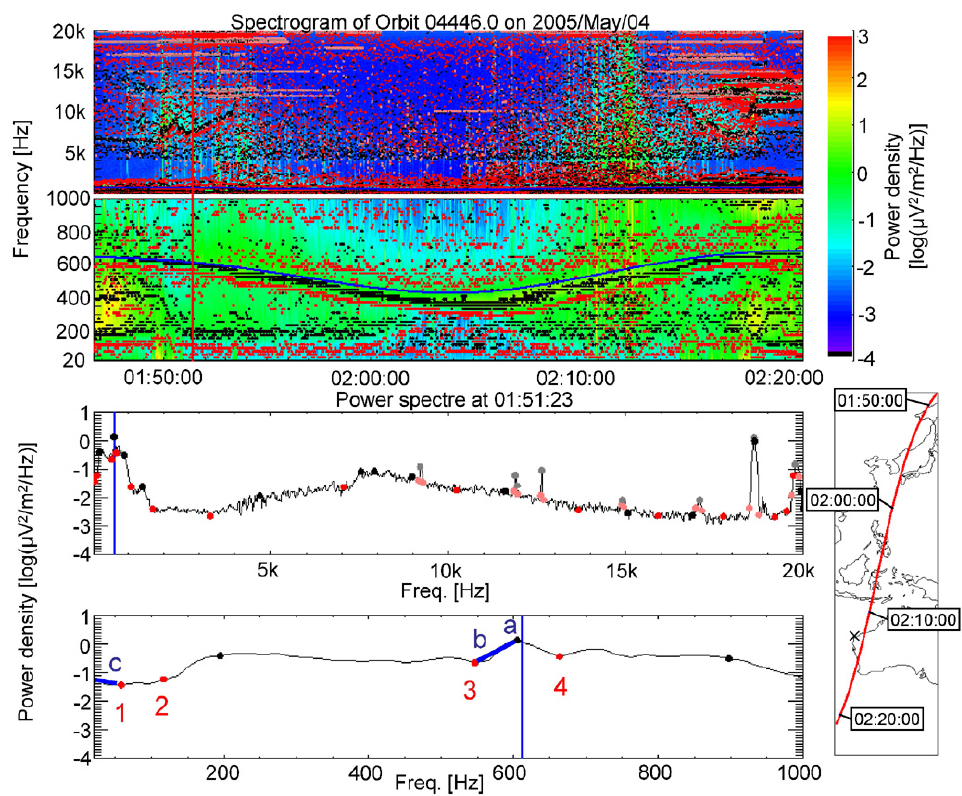
Fig. 1. A spectrum with the characteristic points, f H + shown by the blue line. Characteristic points of positive 2nd derivative are numbered in an order of increasing frequency.